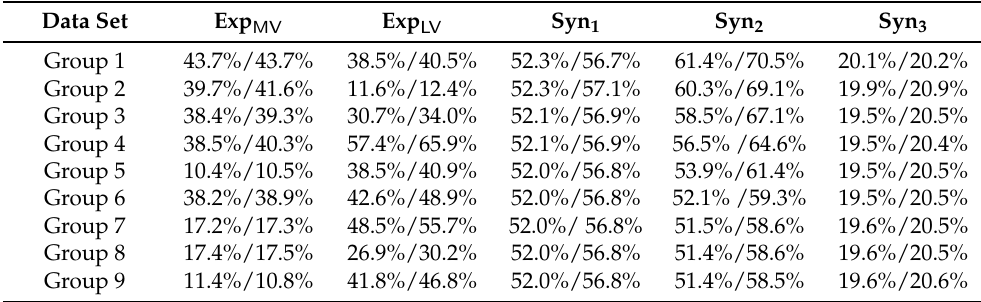
Table 2. Normalized RMSE performance of time-series prediction for the average SNR of all stabilizer batches using the ARIMA(2, 0, 1) and the baseline predictors. Results are shown as ARIMA(2, 0,